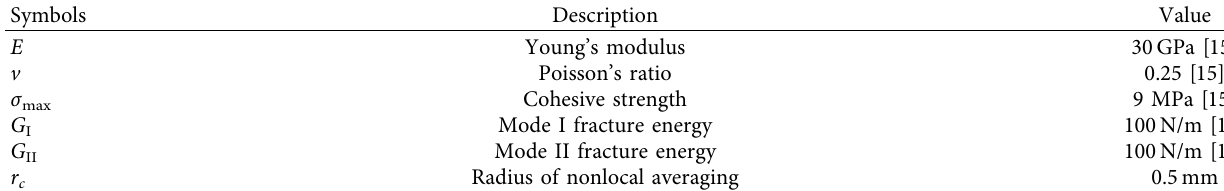
Table 1: The basic parameters for the numerical simulations.